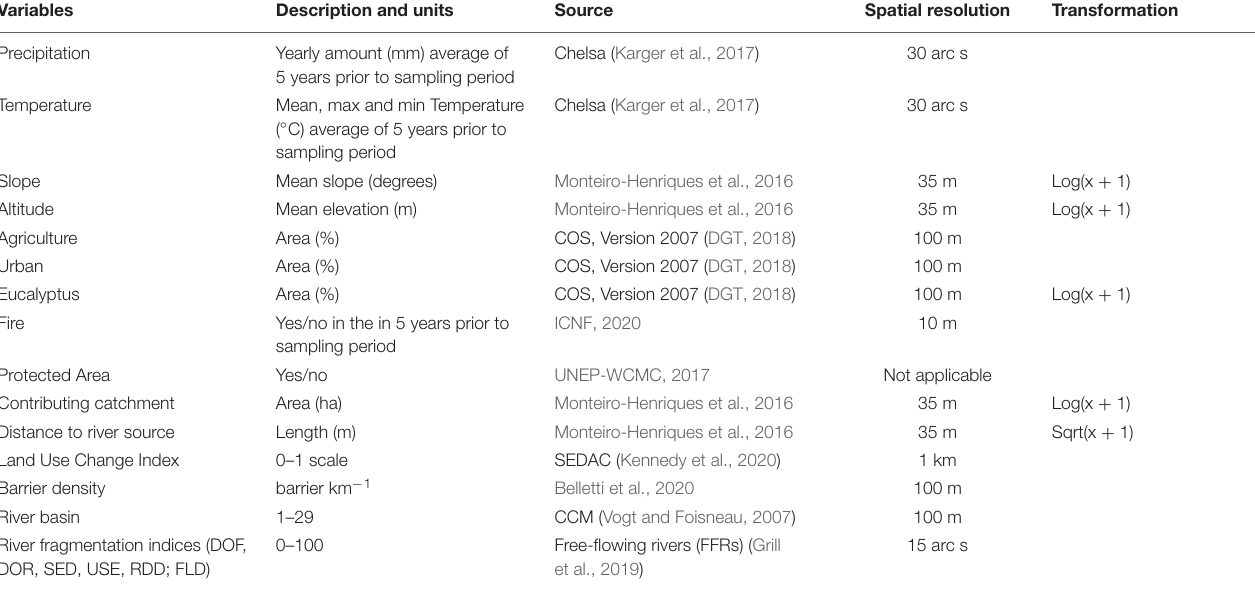
TABLE 1 | Covariates used in the generalized additive model aiming to explain and predict spatial variation in values of richness of invasive alien plants in riparian ecosystems. Variables Description and